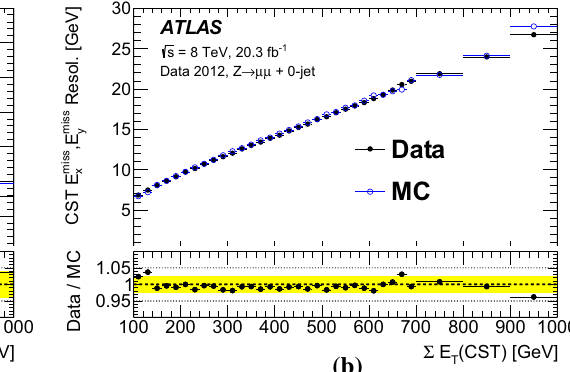
onto ˆ p hard and b the Gaussian in the lower portion of the plot with the solid band representing the T T assigned systematic uncertainty